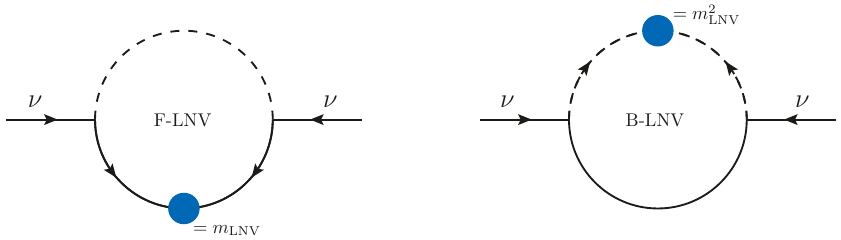
Figure 2 . Lepton-number-violating neutrino self-energy diagrams at the 1-loop level. To connect two external neutrino lines, the loop can only consist of a bosonic line and a fermionic line. To generate Majorana neutrino masses, the loop must contain lepton number violation (indicated by the blue blobs). This can enter either in the fermionic part (left plot) or in the bosonic part (right) of the loop. Throughout this paper, we refer to the former as F-LNV and the latter as B-LNV. be computed using the right diagram in (cid:12)gure 1 instead of the left standard diagram. The amplitude of the standard diagram is proportional to Majorana mass m